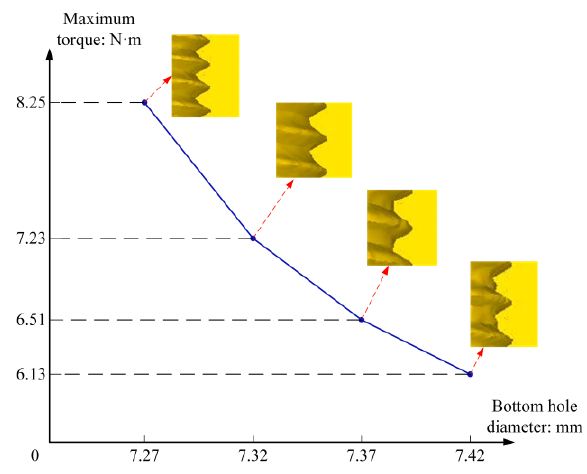
Figure 5. Influence of bottom hole diameter on extrusion effect.